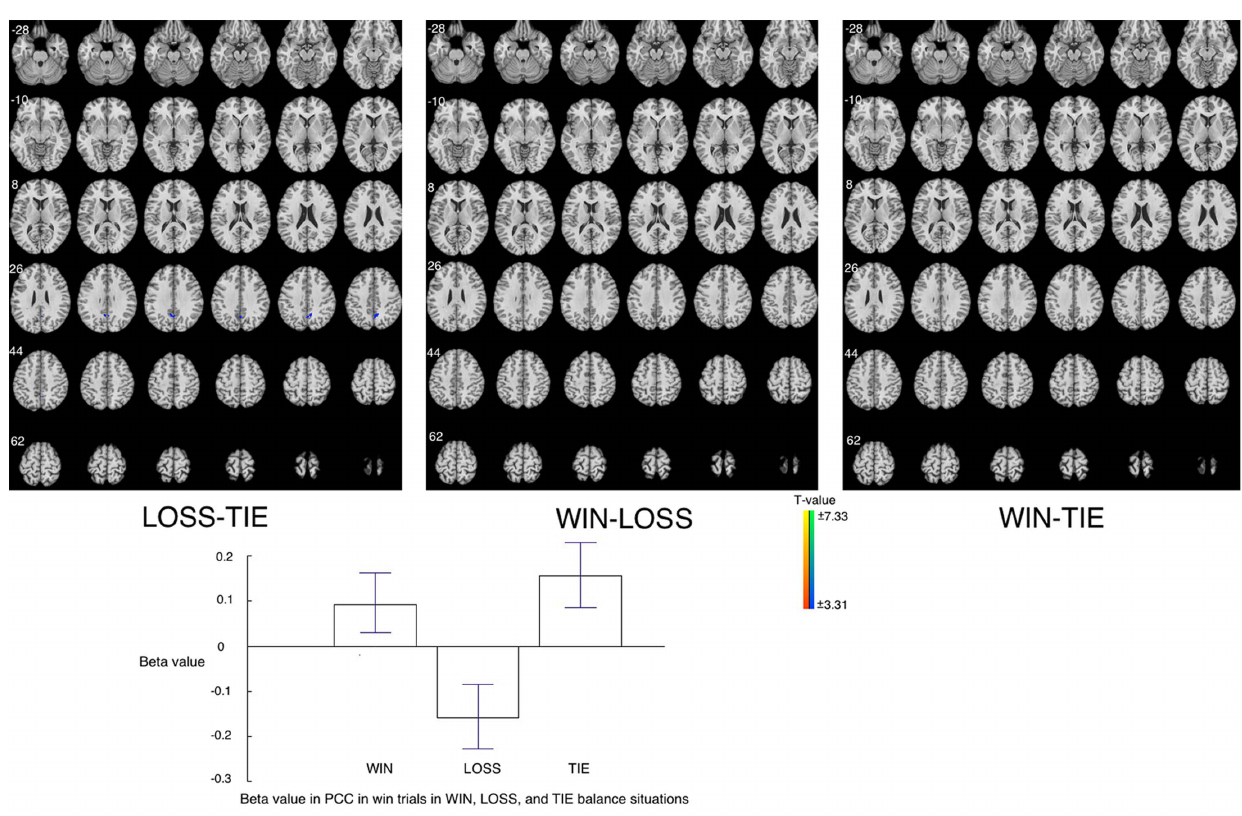
Figure 5. Brain areas showing different activations after lose trials among WIN, LOSS, and TIE situations. Upper: Comparisons among WIN, LOSS and TIE conditions after loss trials. Bottom: The Beta figures in Insula, ACC, and SFG in lose trials in different situations.